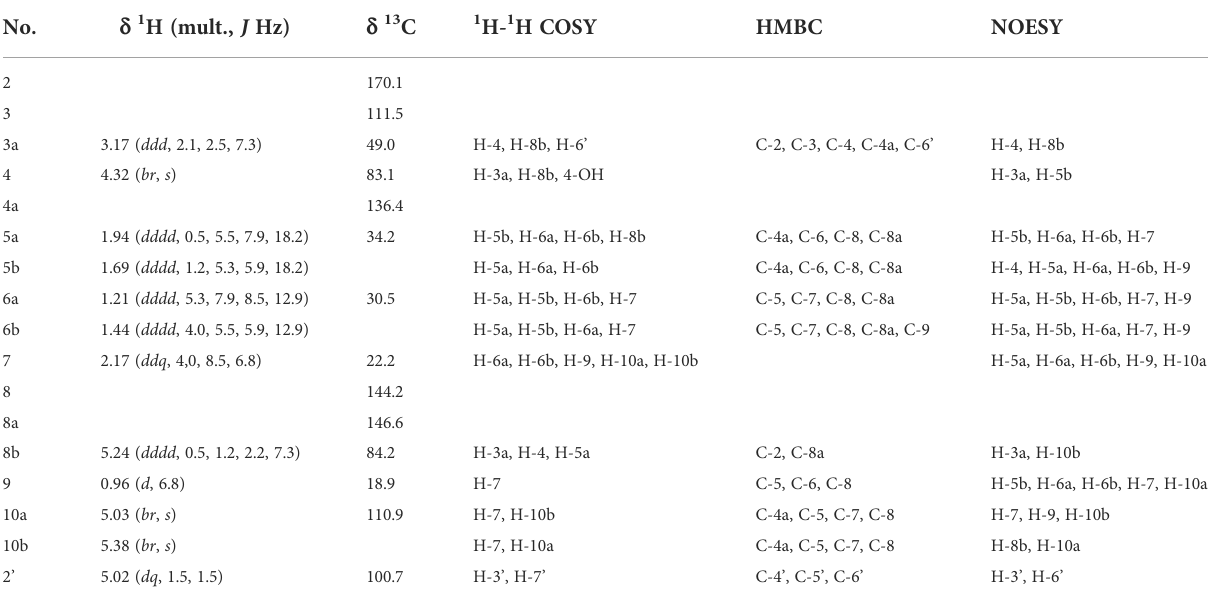
TABLE 2 NMR spectroscopic data of